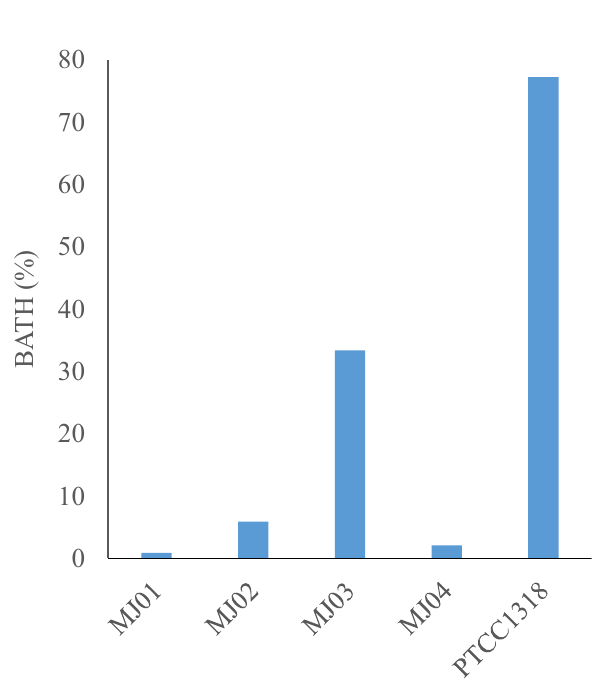
Fig. 2 Bacterial adhesion to hydrocarbon (BATH) for microorgan- isms used in this work; MJ03 and PTCC 1318 have a significant hydrophobicity, whereas the hydrophobicity of the remaining three strains is